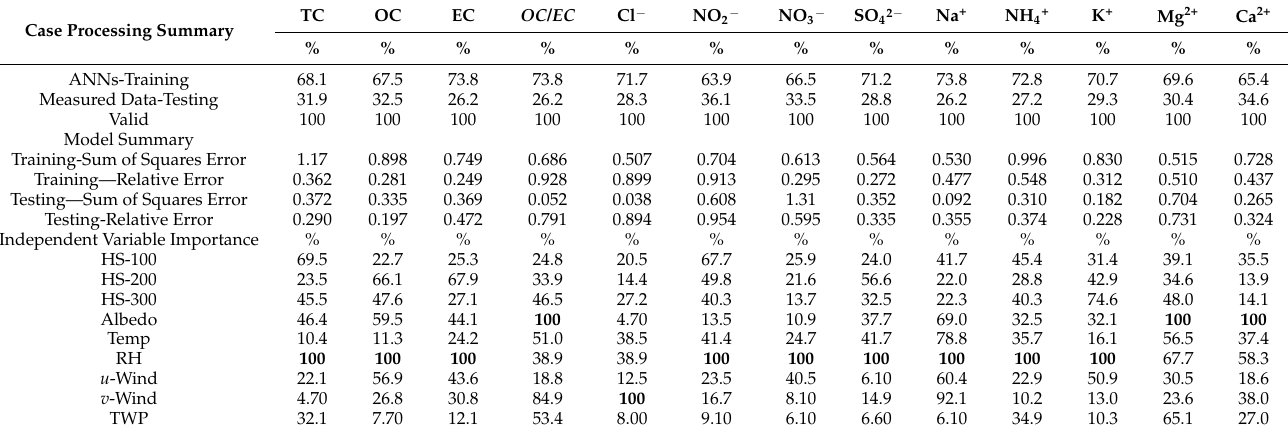
Table 6. The case processing summary and independent variable importance using an artificial neural